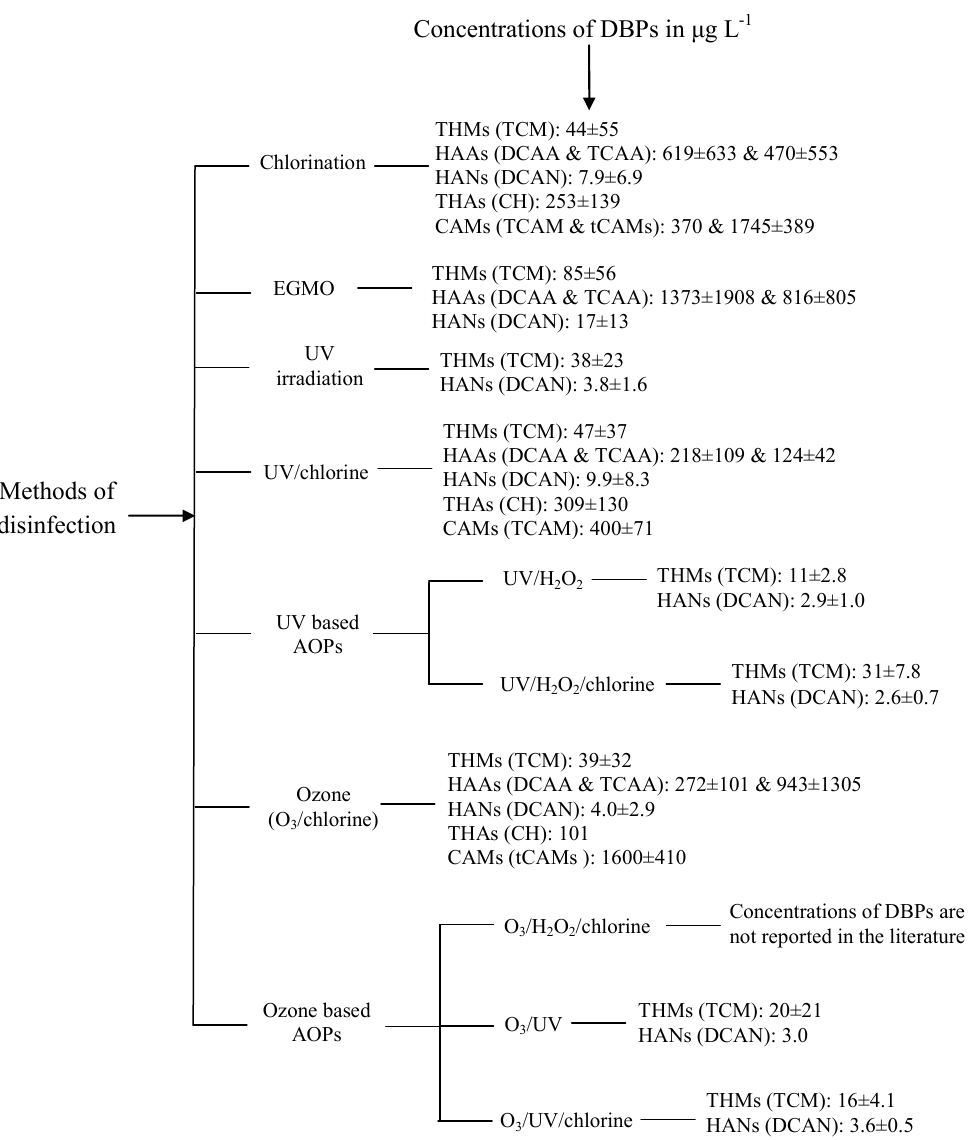
Figure 6. A graphical summary of concentrations of DBPs with different disinfection methods examined in this study.